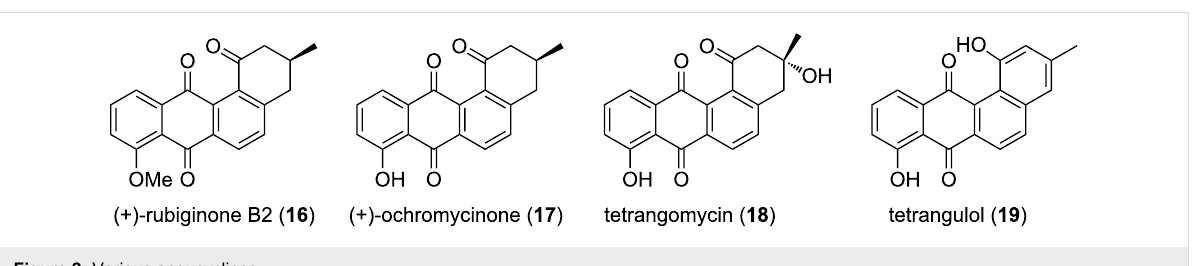
Figure 2: Various angucyclines.